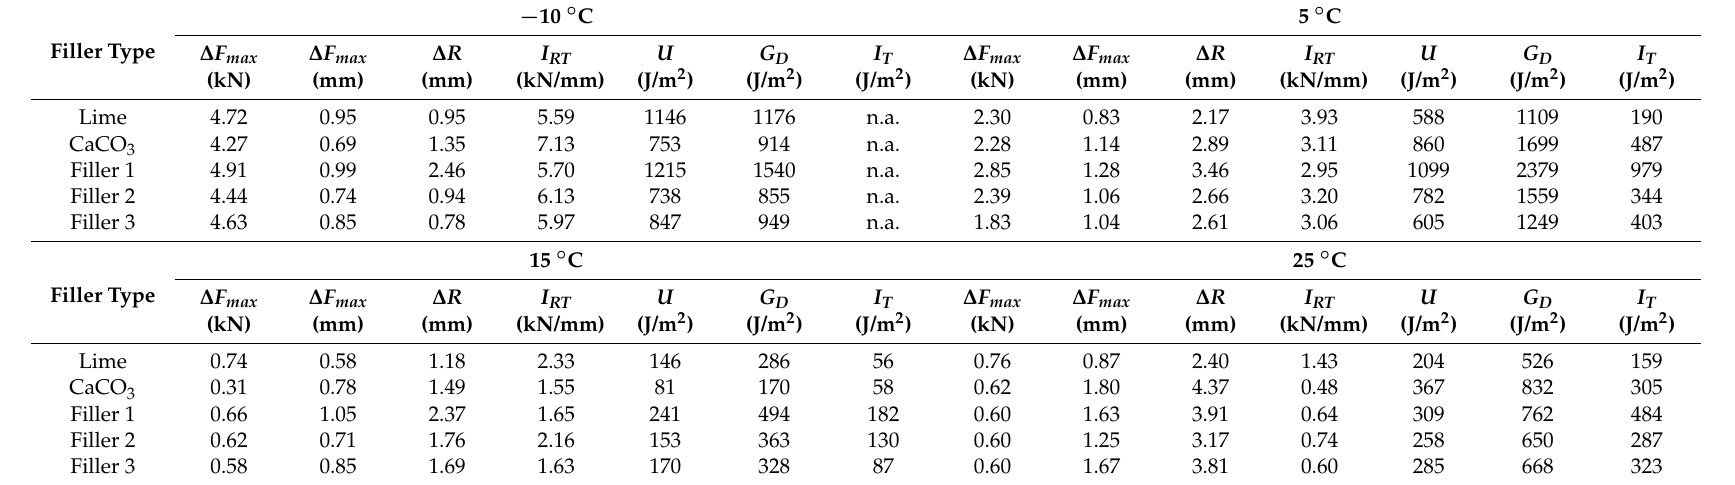
Table 6. The results for all fillers analyzed in the SCB test at − 10 ◦ C, 5 ◦ C, 15 ◦ C and 25 ◦